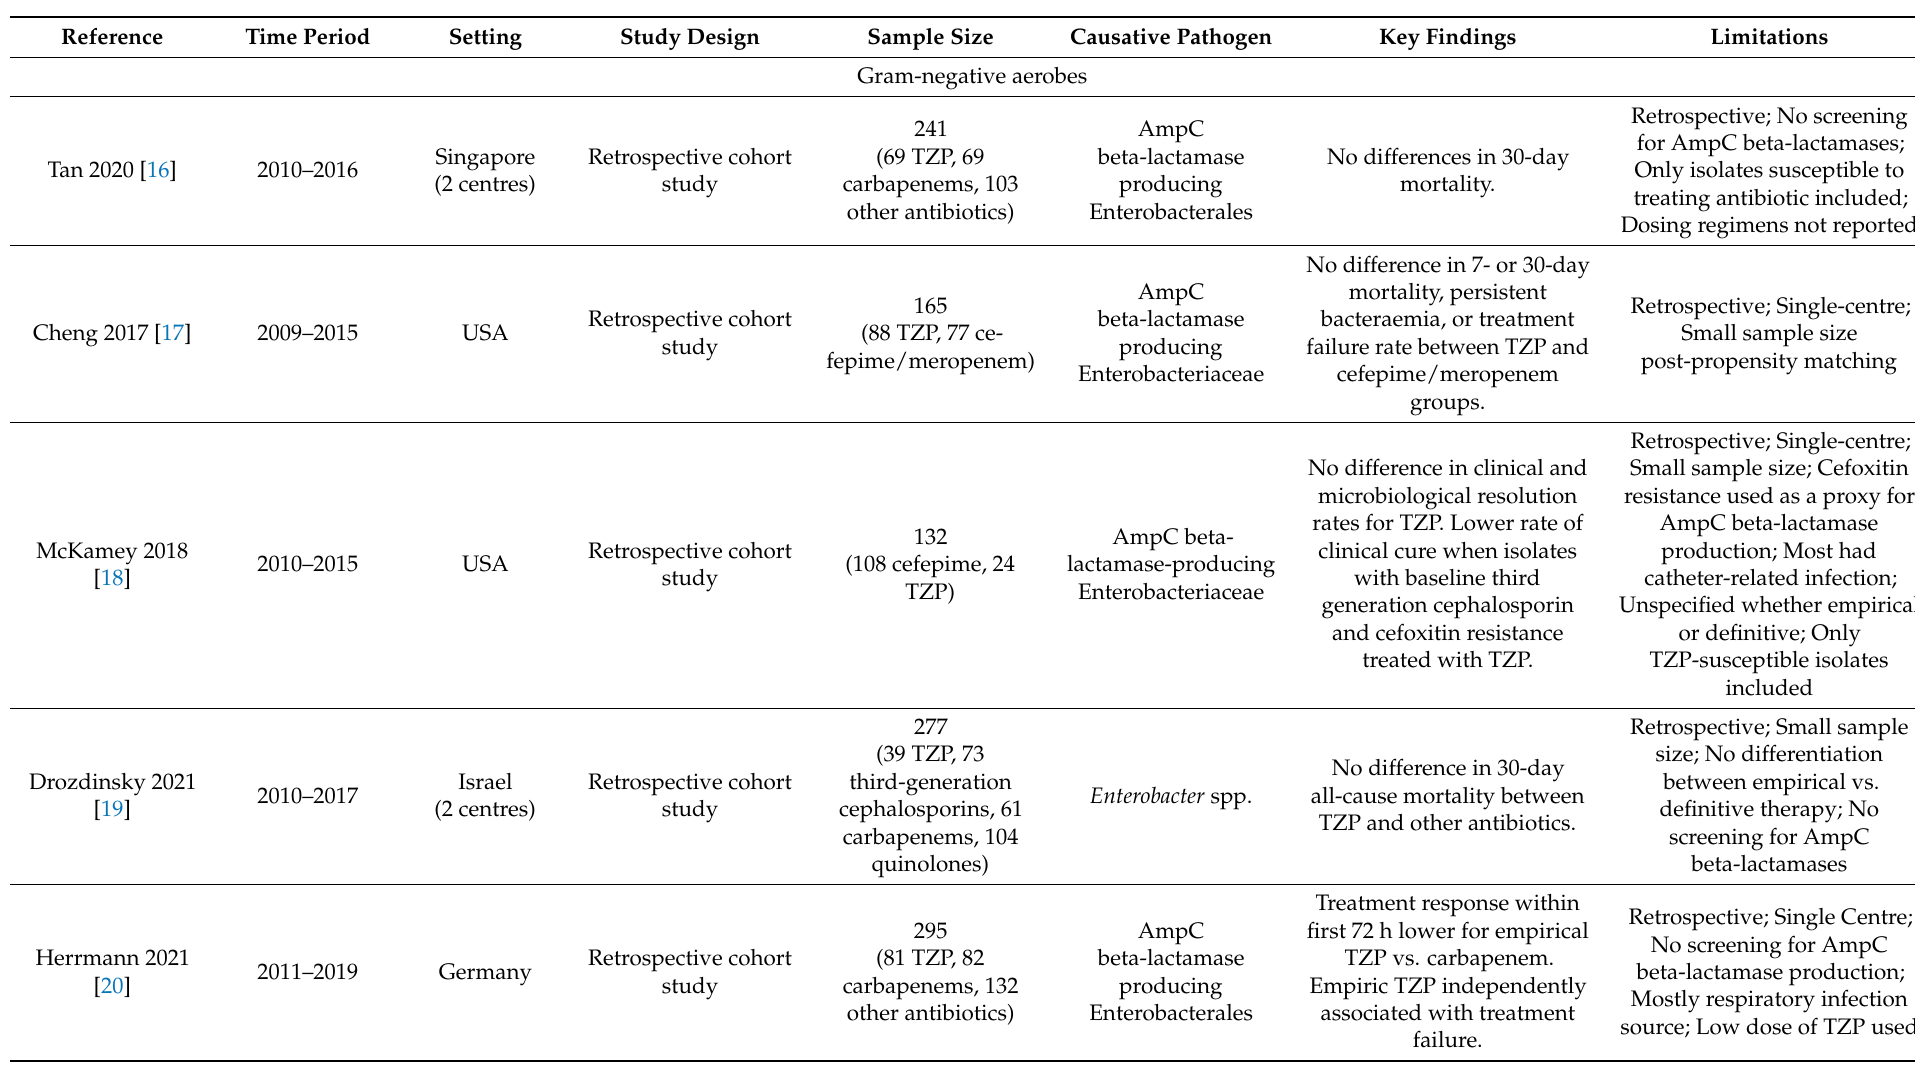
Table 1. Studies addressing the clinical efficacy of TZP as monotherapy in